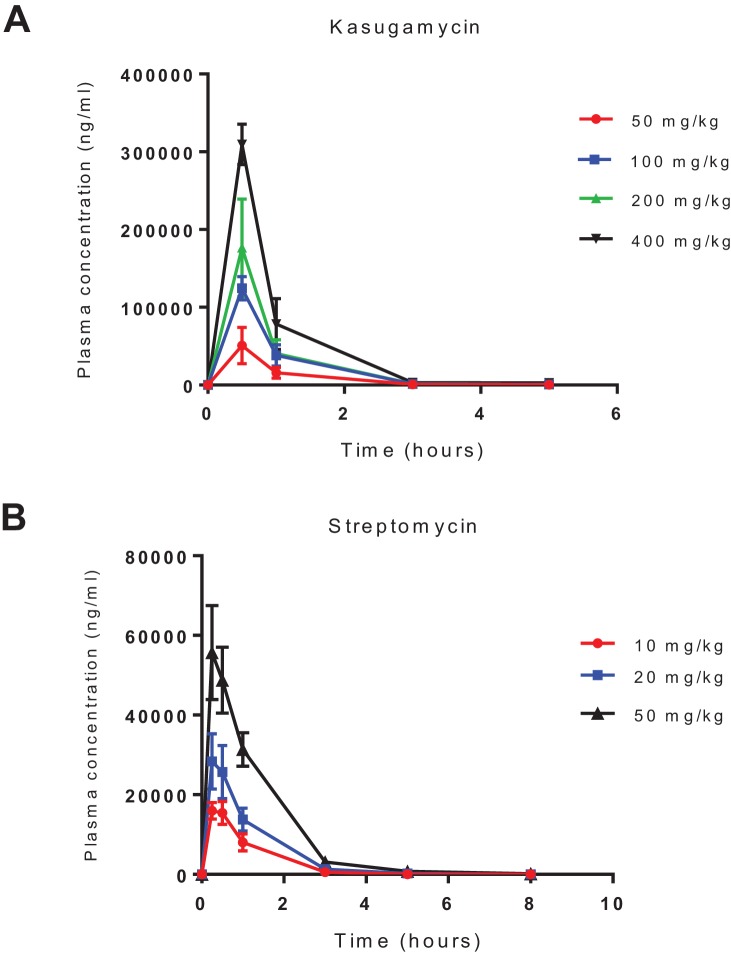
Pharmacokinetics of intra-peritoneal administration of kasugamycin and streptomycin.Kasugamycin (top) and streptomycin were given by intra-peritoneal injection and plasma concentration measured by liquid chromatography mass-spectrometry.